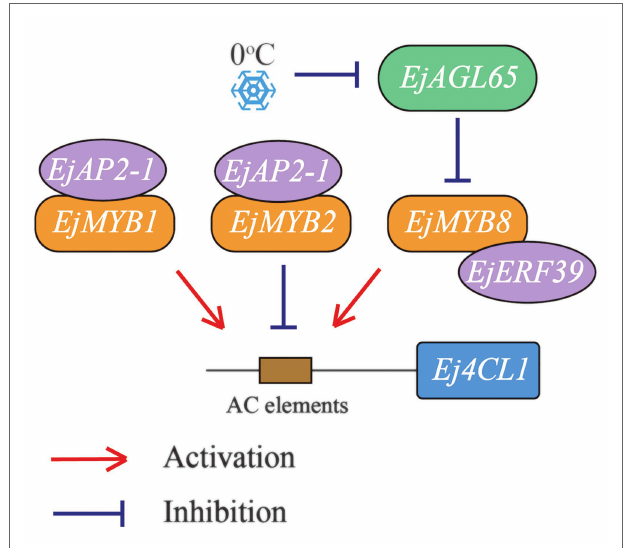
FIGURE 6 | Regulatory routes identified based on Ej4CL1 . Three MYB genes are physically associated with Ej4CL1 , acting as mediators for binding with other transcription factors. Both EjMYB1 and EjMYB2 can recruit EjAP2- 1 to repress their transcriptional activities. EjMYB8 is controlled at both protein level (by EjERF39) and mRNA level (by EjAGL65). Lines with an arrow or a dashed terminal indicate activation or repression, respectively. Two genes shown in a sequence indicate a confirmed protein-protein interaction with each